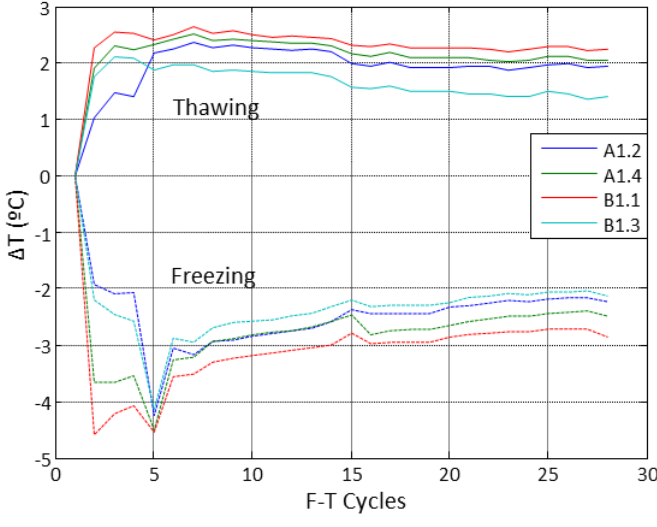
Figure 12. Difference of temperature between concrete specimens and climatic chamber.